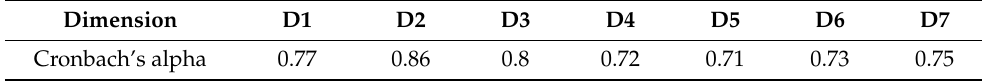
Table 5. Cronbach’s alpha values for each dimension as a reliability measure. Dimension